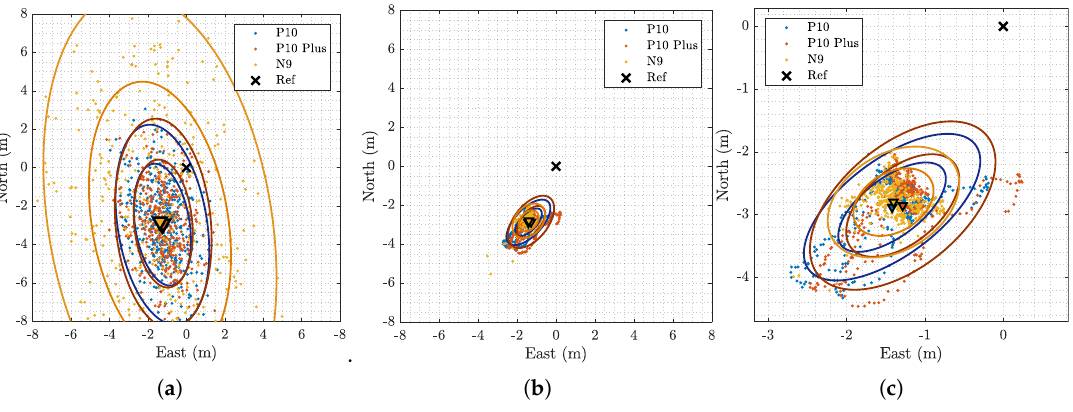
Figure 11. Position comparison between devices in a controlled environment. ( a ) Smoothing OFF; ( b ) Smoothing ON with weight L = 50; ( c ) Smoothing ON with weight L = 50